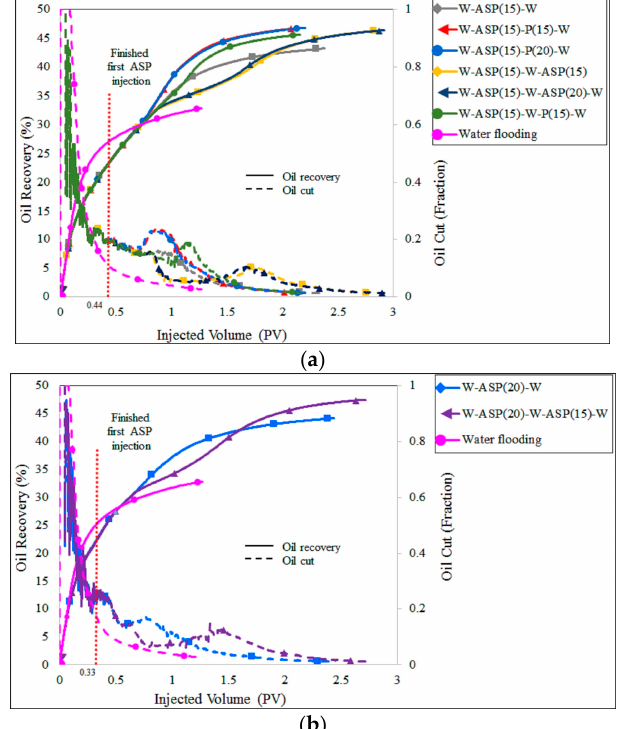
Figure 6. Oil production performance of water flooding and the sequences of the (ASP) group: ( a ) first chemical slug is 15 cp ASP solution; ( b ) first chemical slug is 20 cp ASP solution. The repeated injections of ASP solution with a slug of water in between achieve the highest oil recovery than the sequences using a buffering polymer solution.